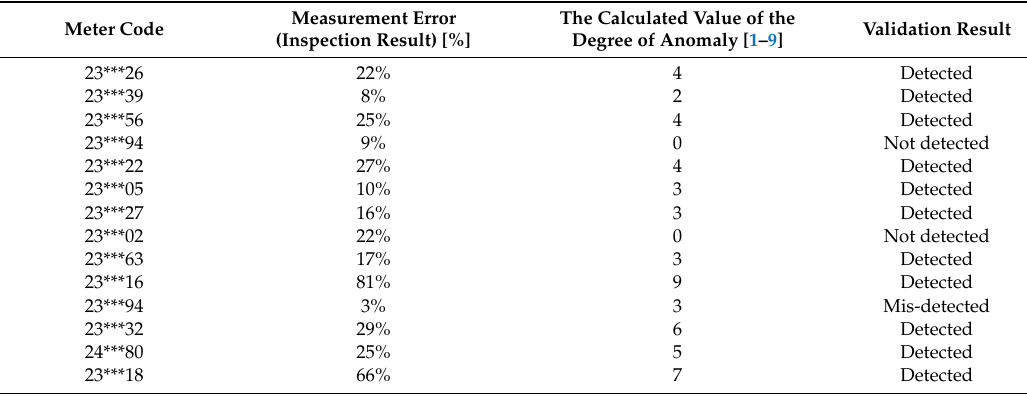
Table 4. Comparison of simulation results and test results for meters of study area.